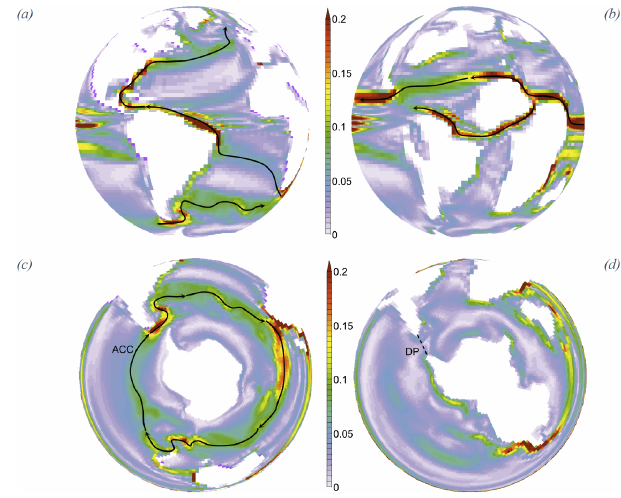
Figure 7. Surface currents for (a, c) 4X-NOICE-PFT-SOIL- SOLAR and (b, d) 4X-CRETACEOUS simulations. (a, b) Intensity of surface circulation in sverdrups (Sv – annual mean for 0–80m of water depth). Strong equatorial winds lead to the formation of an equatorial circumglobal current. (c, d) Intensity of surface circula- tion (Sv – annual mean for 0–80m of water depth). The closure of the Drake Passage (DP-300m of water depth) leads to the suppres- sion of the ACC.